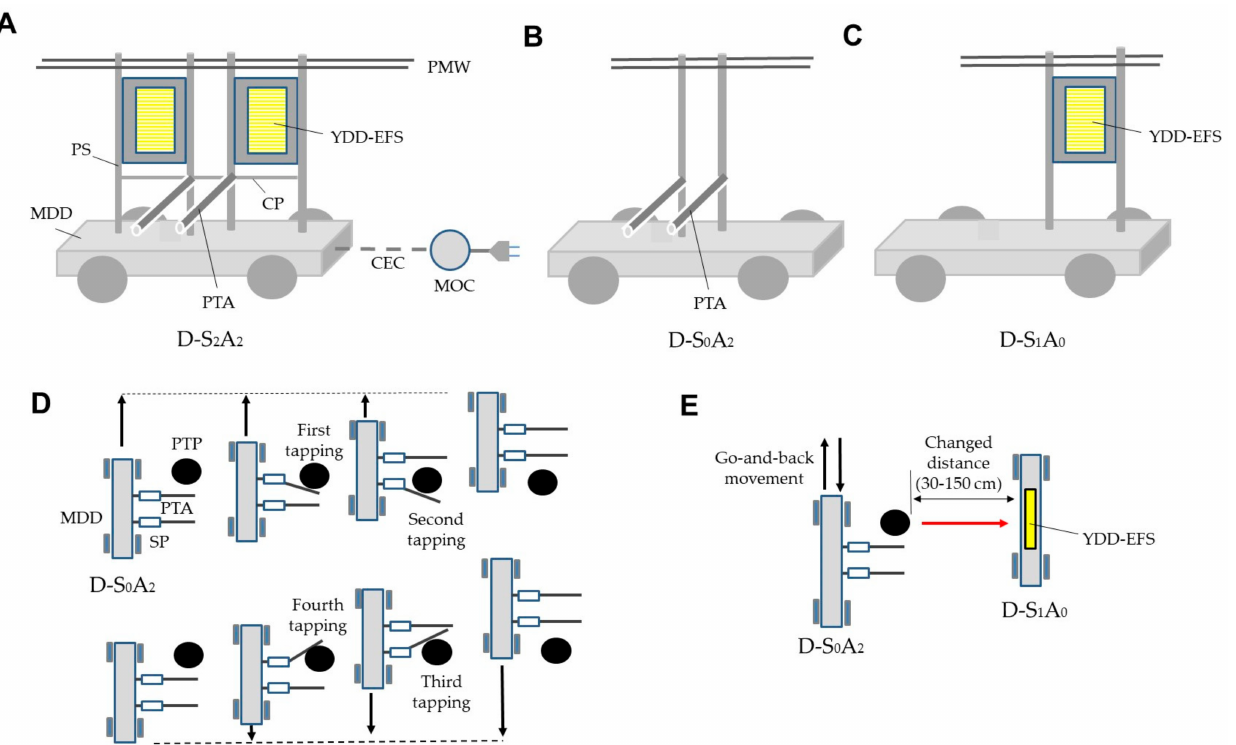
Figure 2. ( A – C ) Three types of motor-driven dollies that moved two yellow-colored double-charged dipolar electric field screens (YDD-EFSs): a dolly with two arms for plant touching (D-S 2 A 2 ) ( A ), a dolly with no YDD-EFS and two arms (D-S 0 A 2 ) ( B ), and a dolly with one YDD-EFS and no arm (D-S 1 A 0 ) ( C ). The dolly motor was manually remote-controlled. ( D ) Step-by-step forward (upper) and backward (lower) D-S 0 A 2 motion with tapping of a potted tomato plant by the two arms. The plant was tapped four times with the two elastic arms via reciprocating movements of the D-S 0 A 2 (bird’s-eye view). ( E ) Experimental assay of flying whitefly attraction by the YDD-EFS on the D-S 1 A 0 dolly placed at various distances from a tomato plant to which whiteflies had been transferred. Black and red arrows represent the direction of dolly movement and path of the whiteflies attracted to the YDD-EFS, respectively. Abbreviations: MDD, motor-driven dolly; PS, polypropylene supporter; PTA, plant-touching arm; YDD-EFS, yellow-colored double-charged dipolar electric field screen; CP, crosspiece; CEC, coiled extension electric cable; MOC, motor-operation controller; PMW, paired metal wires; PTP, potted tomato plant; SP, spring-jointed short and long